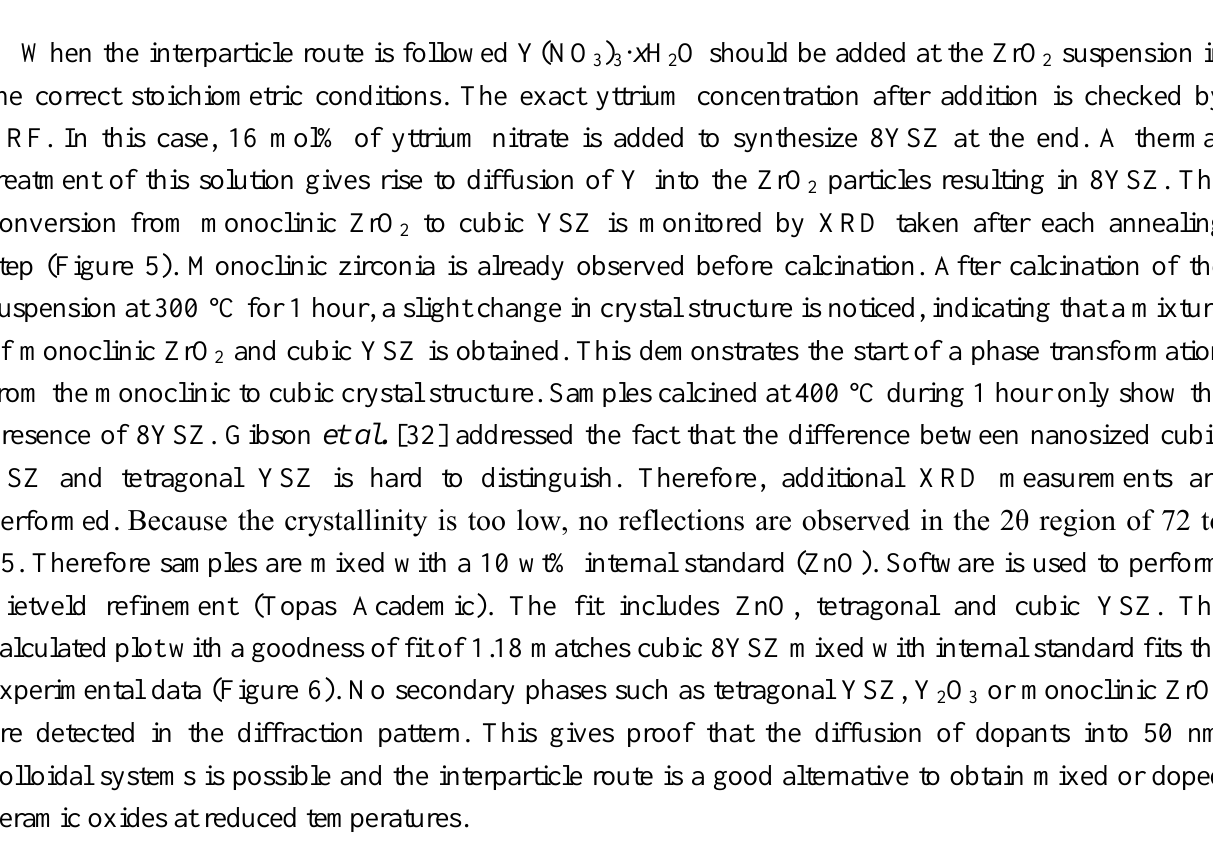
nanoparticles 2 ; and C the 2